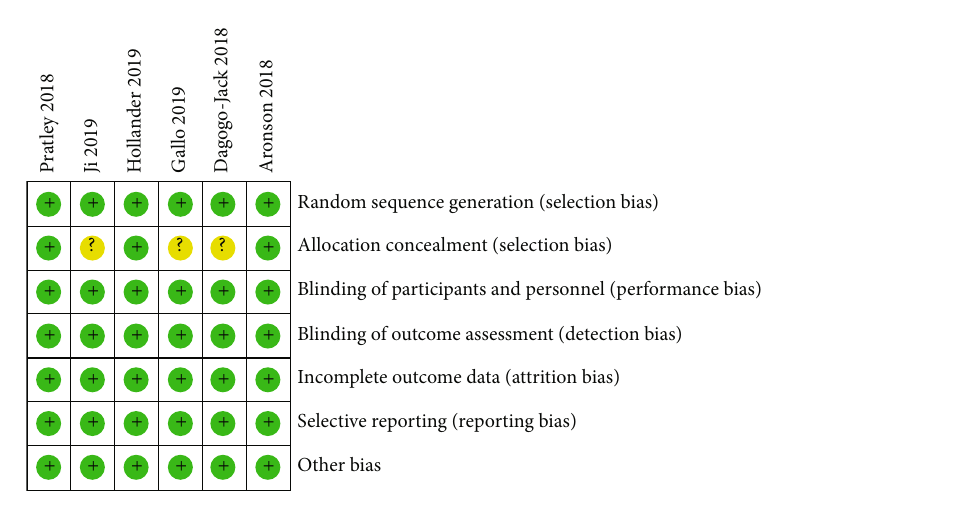
Figure 2: Risk of bias